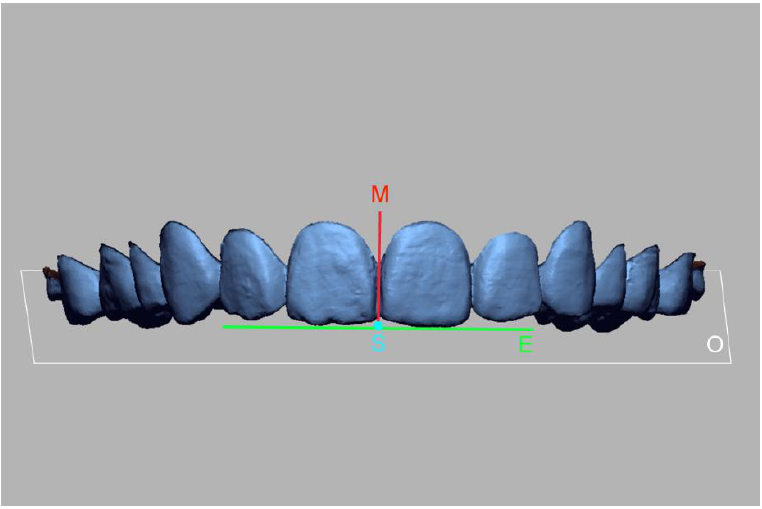
Figure 6. Landmarks for the evaluation of the spatial positional accuracy of the dentofacial integration. M, interincisal midline; O, occlusal plan; S, intersection point of the midline and the occlusal plan; E, incisor edge line.